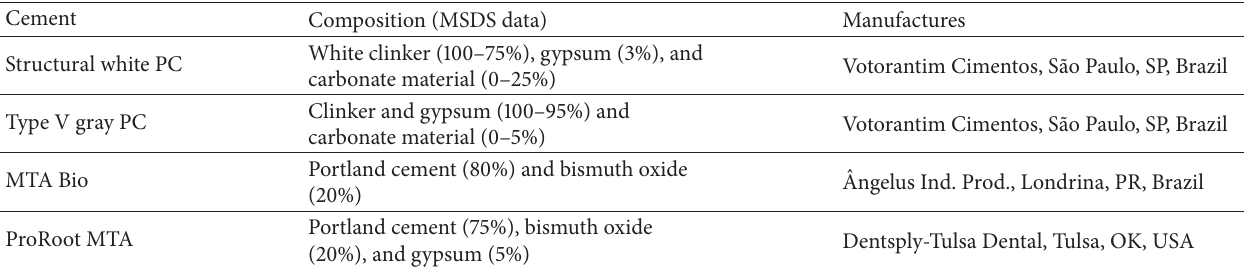
Table 1: Composition of the materials and their